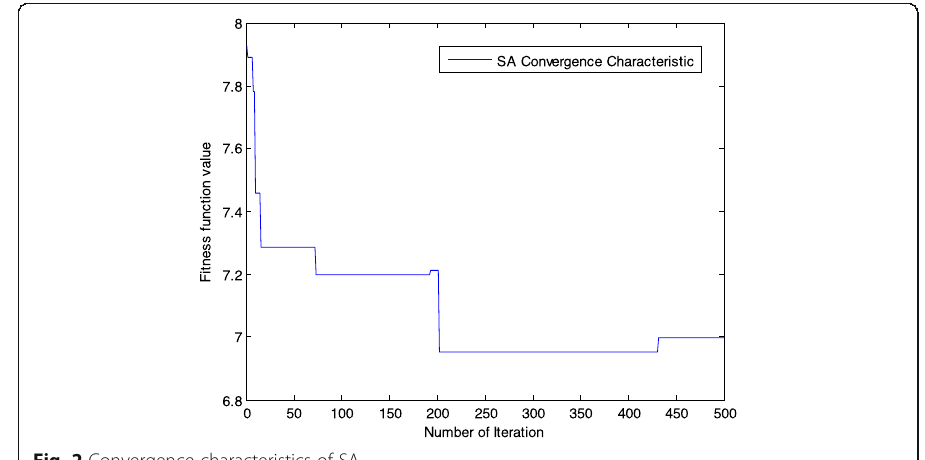
Fig. 2 Convergence characteristics of